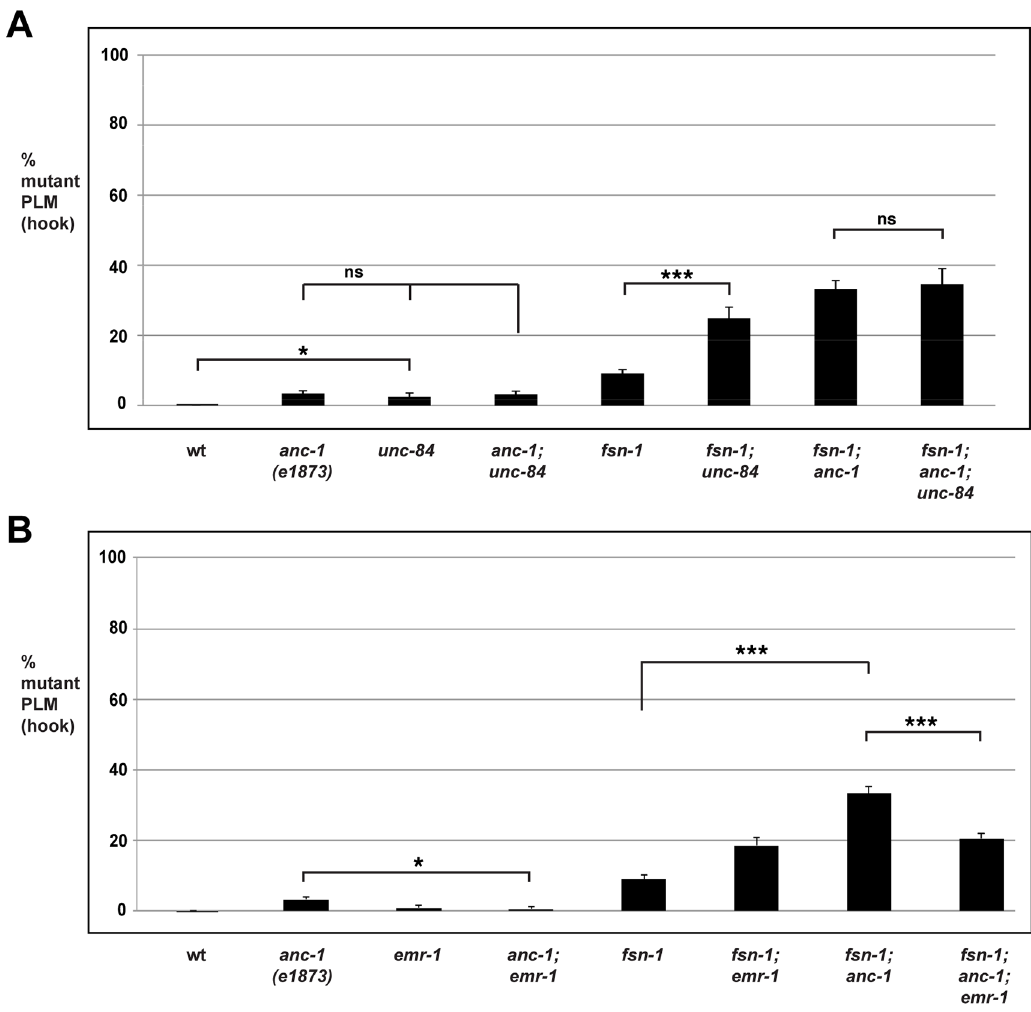
Figure 6. anc-1 and unc-84 function in the same genetic pathway to regulate axon termination. Quantitation of axon termination defects (hook) in PLM neurons for the indicated genotypes using muIs32 . (A) unc-84 mutant analysis. (B) emr-1 mutant analysis. Analysis was done on young adults grown at 23 u C. Significance was determined using an unpaired Student’s t test; error bars represent the standard error of the mean. * P , 0.05, *** P , 0.001, ns=not